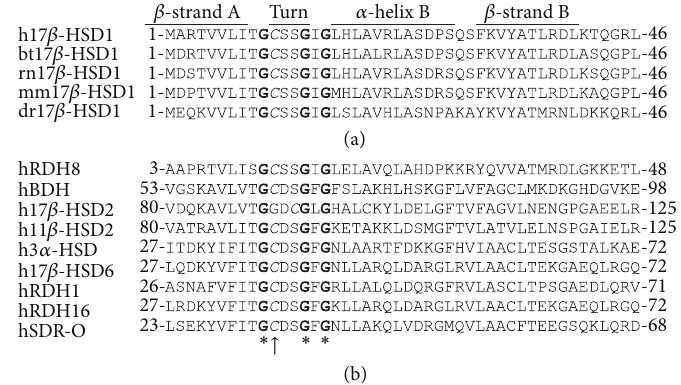
Figure 1: Sequence alignment of the cofactor binding domain of 17 𝛽 -HSD1. Peptide sequences of human (h), bovine (bt), rat (rn), mouse (mm), and zebrafish (Danio rerio, dr) 17 𝛽 -HSD1 (SDR28C1) are shown in the upper panel and those of the related human SDR enzymes all-trans retinol dehydrogenase RDH8 (SDR28C2), hydroxybutyrate dehydrogenase BDH (SDR9C1), 17 𝛽 -HSD2 (SDR9C2), 11 𝛽 -HSD2 (SDR9C3), 3 𝛼 -HSD (SDR9C4), 11-cis retinol dehydrogenase (SDR9C5), 17 𝛽 -HSD6 (SDR9C6), retinol dehydrogenase SDR-O (SDR9C7), and retinol dehydrogenase RDH16 (SDR9C8) in the lower panel . The locations of 𝛽 -strand A through 𝛽 -strand B are indicated above the alignment. The position of the conserved Cys 10 on 17 𝛽 -HSD1 is indicated by an arrow and the conserved glycine residues of the Rossmann- fold by asterisks ( in bold